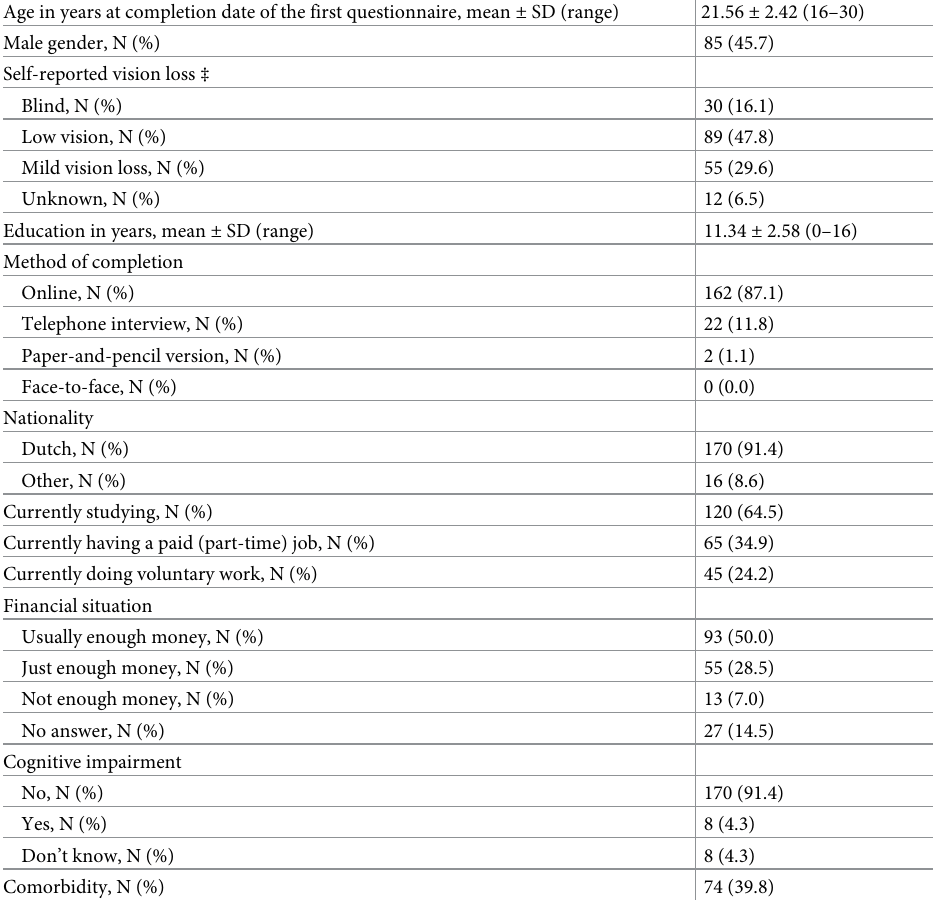
Table 1. Socio-demographic characteristics of participants (N = 186). Age in years at completion date of the first questionnaire, mean ± SD